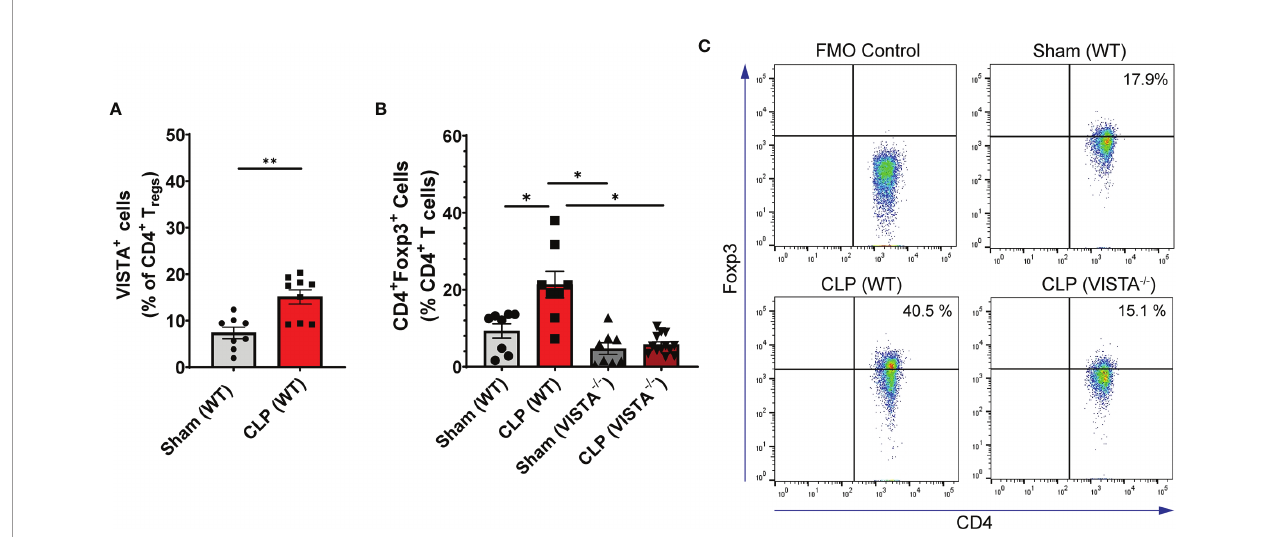
FIGURE 3 | VISTA expression correlates with CD4 + T reg population increase following CLP and VISTA -/- mice fail to expand the CD4 + T reg population in the spleen. (A) Summary graph of VISTA + CD4 + T reg frequency in the spleen. (B) Summary graph of CD4 + T reg frequency in the spleen and (C) representative fl ow cytometry plots comparing fl uorescence minus one (FMO) control, sham (WT), CLP (WT), and CLP (VISTA -/- ) samples. Summary graphs show mean ± SEM [WT-sham: n = 8 , WT-CLP: n = 8 , VISTA -/ – sham: n = 8 , VISTA -/- -CLP: n = 13 ]; signi fi cance *p < 0.05; **p <